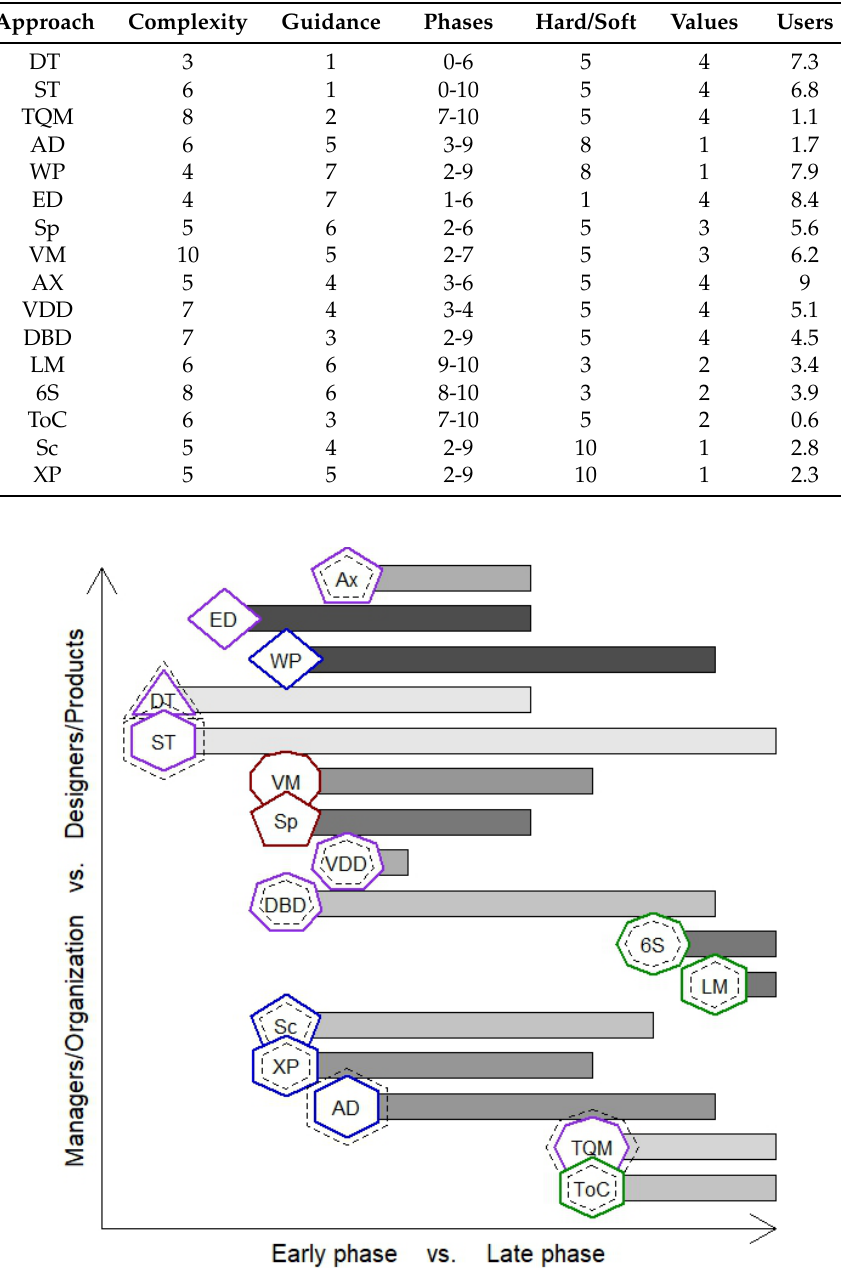
Figure 1. Graphical representation of approaches and criteria; phase represented by horizontal position, users by vertical position, complexity by number of polygon sides, guidance by darkness of bar shading, values by color of polygon outline (blue = time, green = cost, red = risk, purple = marketability), category by dashed outline (inner = method, none = process, outer = environment); hard/soft is not